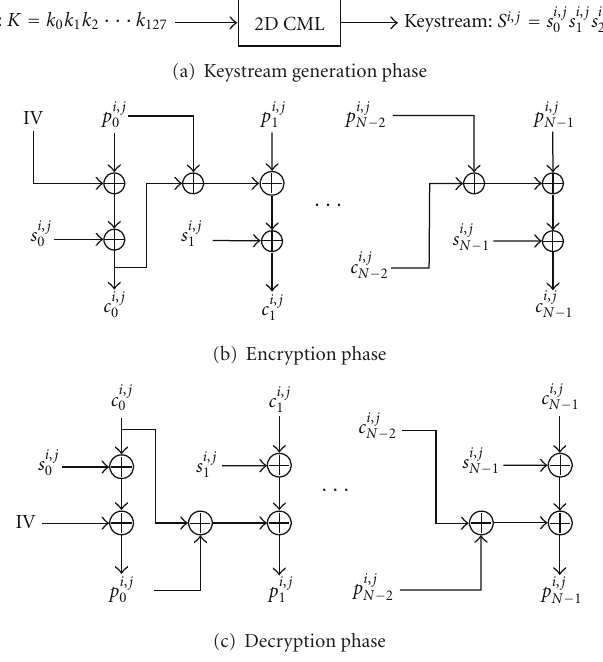
Figure 1: The enhanced spatiotemporal chaotic image/video